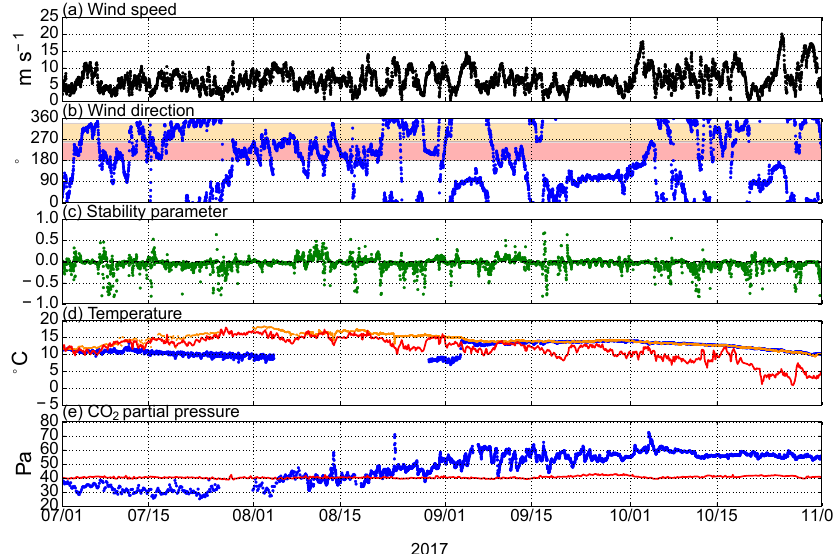
Figure 3. Environmental conditions at Utö in July–November 2017: (a) wind speed, (b) wind direction (red band indicates the directions used for sea–air flux measurements in this study, and yellow band indicates additional directions that will be considered in the future), (c) stability ( z/L ), (d) air temperature (red) and sea temperature at 4.5m depth (orange) and at 23m depth (blue), and (e) CO 2 partial pressure in air (red) and CO 2 partial pressure in seawater at 4.5m depth (blue). Wind speed, wind direction, stability and air temperature were measured in the flux station (A in Fig. 1). Seawater temperatures and p CO 2 were measured at the inlet (B in Fig. 1). The p CO 2 in air was measured at the ICOS station (C in Fig. 1).